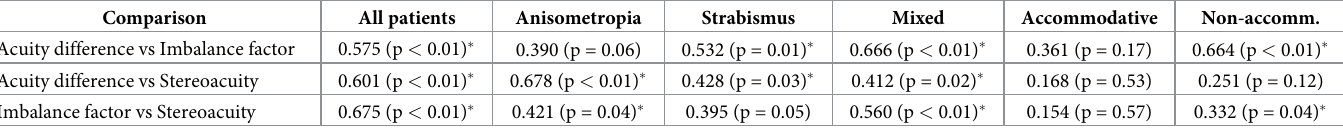
Table 2. Correlation between triplet variables at each clinic group. Correlation values (Spearman test) between pairs of the continuous variables of the study (acuity dif- ference, stereoacuity and imbalance factor), considering all patients and each group individually, classified according to amblyogenic factor (anisometropia, strabismus and mixed) and considering refractive response (accommodative and non-accommodative).